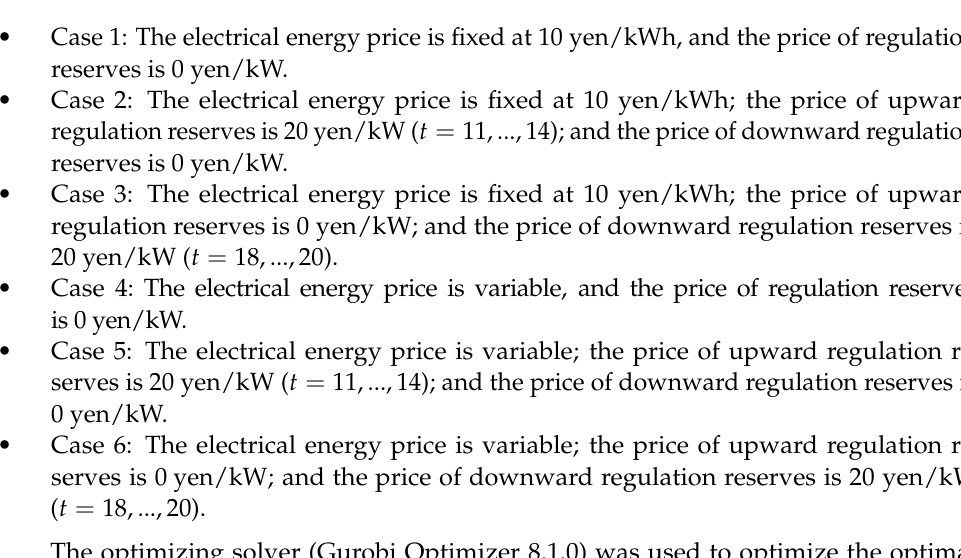
Figure 6. Profile of hourly variable electrical energy prices and incentive price for the provided regulation